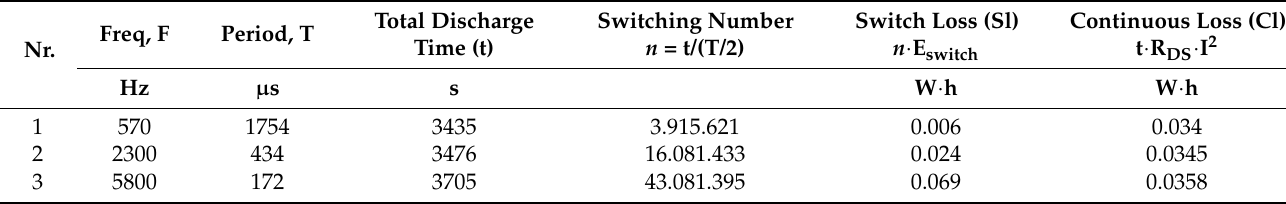
Table 5. The energy loss during